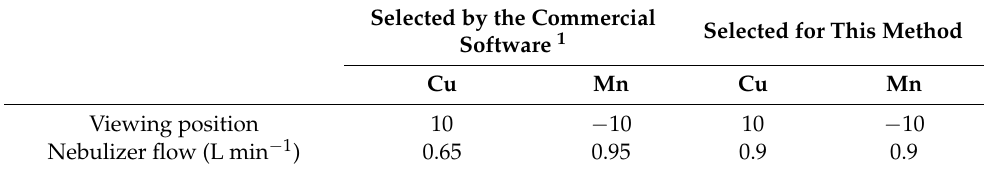
Table 1. Operating conditions microwave-induced plasma optical emission spectrometer (MIP OES). Selected by the Commercial